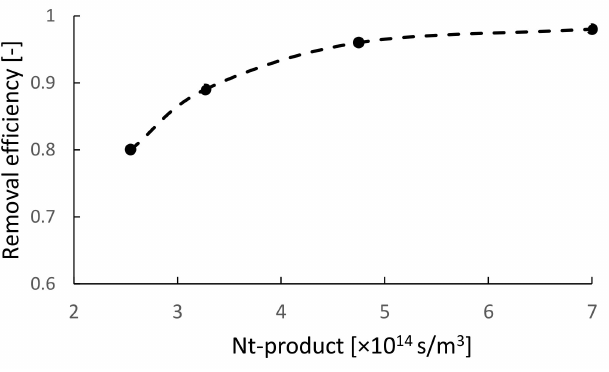
Figure 5. The total removal efficiency with NT-product.